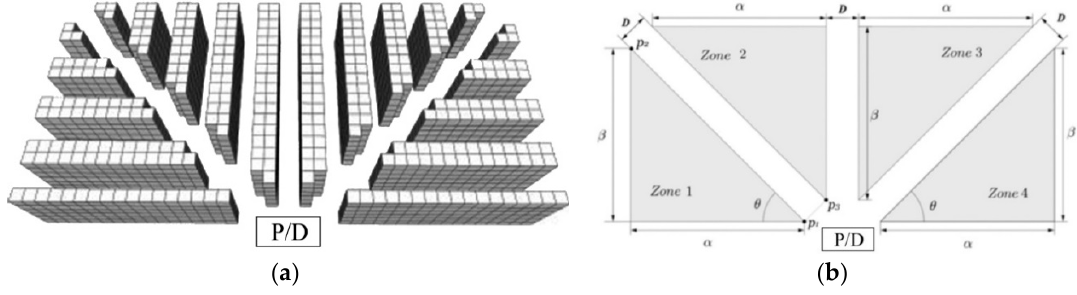
Figure 4. Tridimensional fishbone layout ( a ) and geometrical specification ( b ).